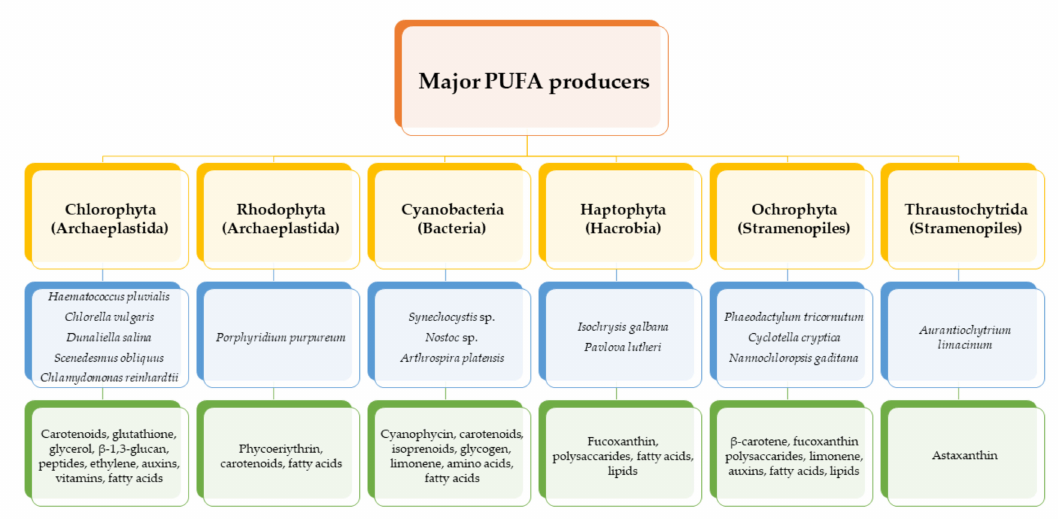
Figure 1. Main polyunsaturated fatty acid (PUFA)-producing microorganisms and associated high-value